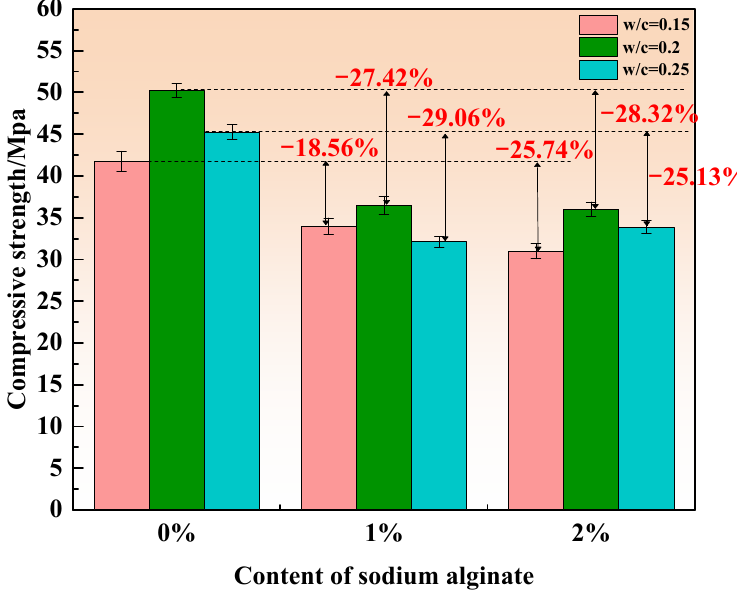
Figure 5. Compressive strength of the MKPCs after 28 days of curing.